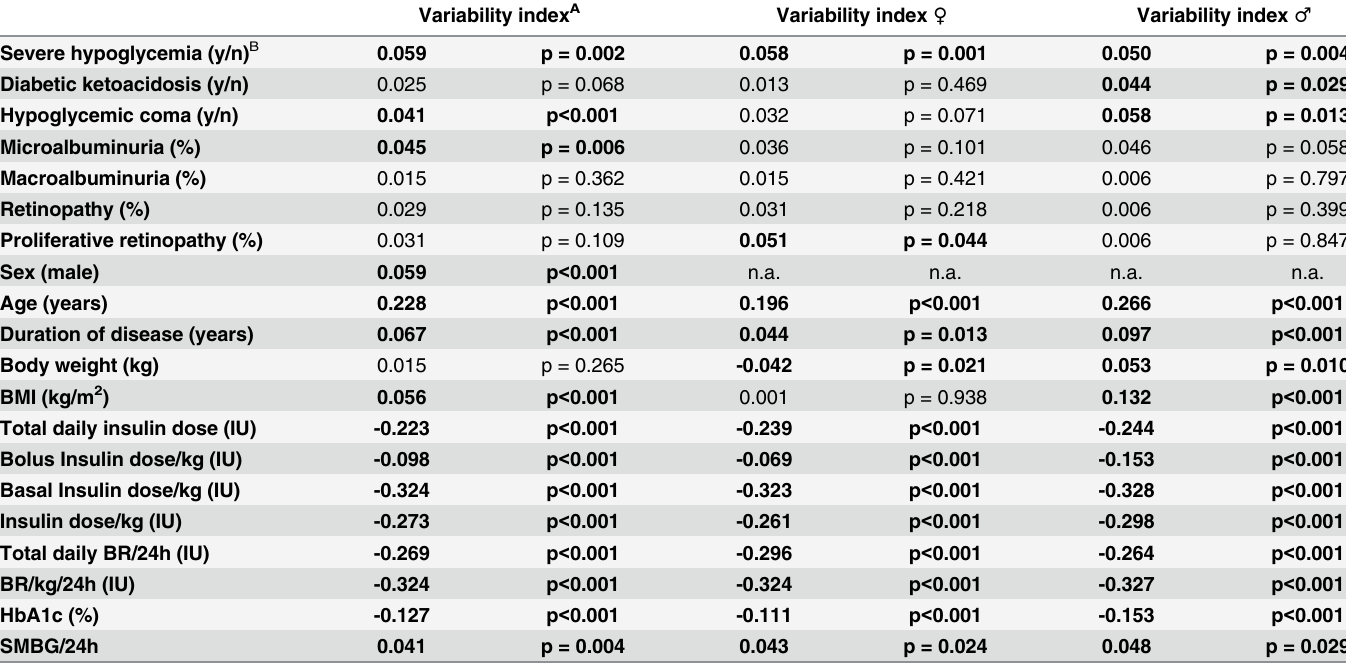
Table 2. Correlations of variability index with acute and chronic complications as well as patient ’ s characteristics in adult type 1 diabetic patients. N = 5545.